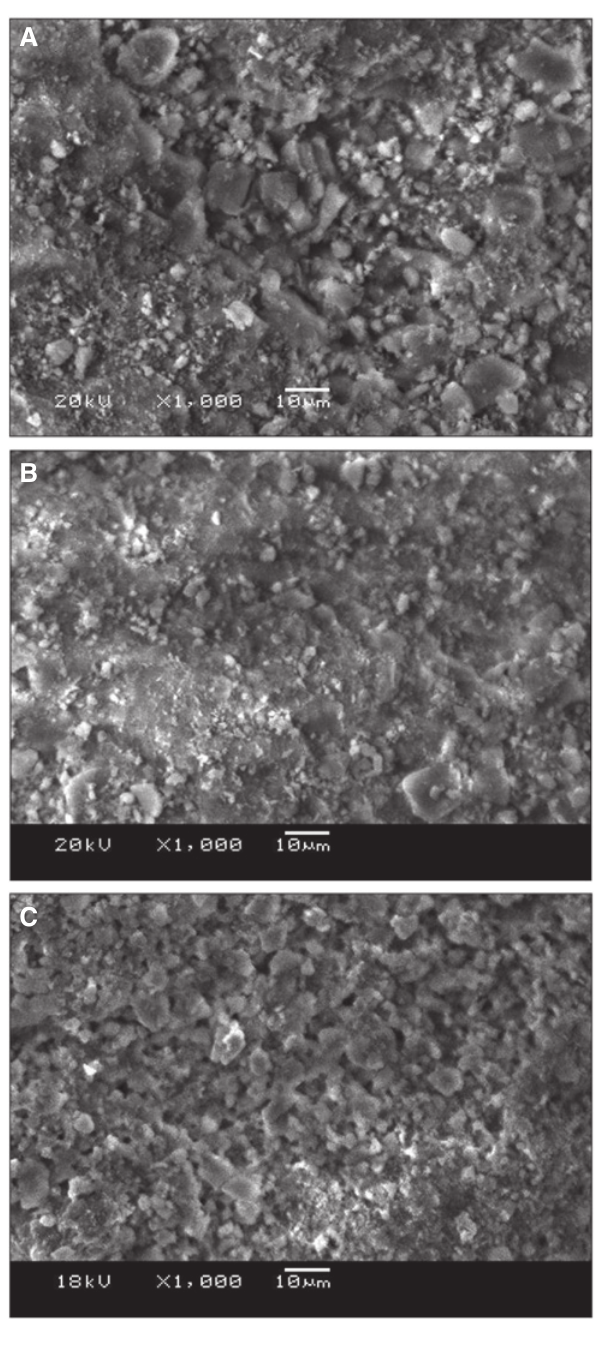
-NiO/ γ -Al O 2 2 3